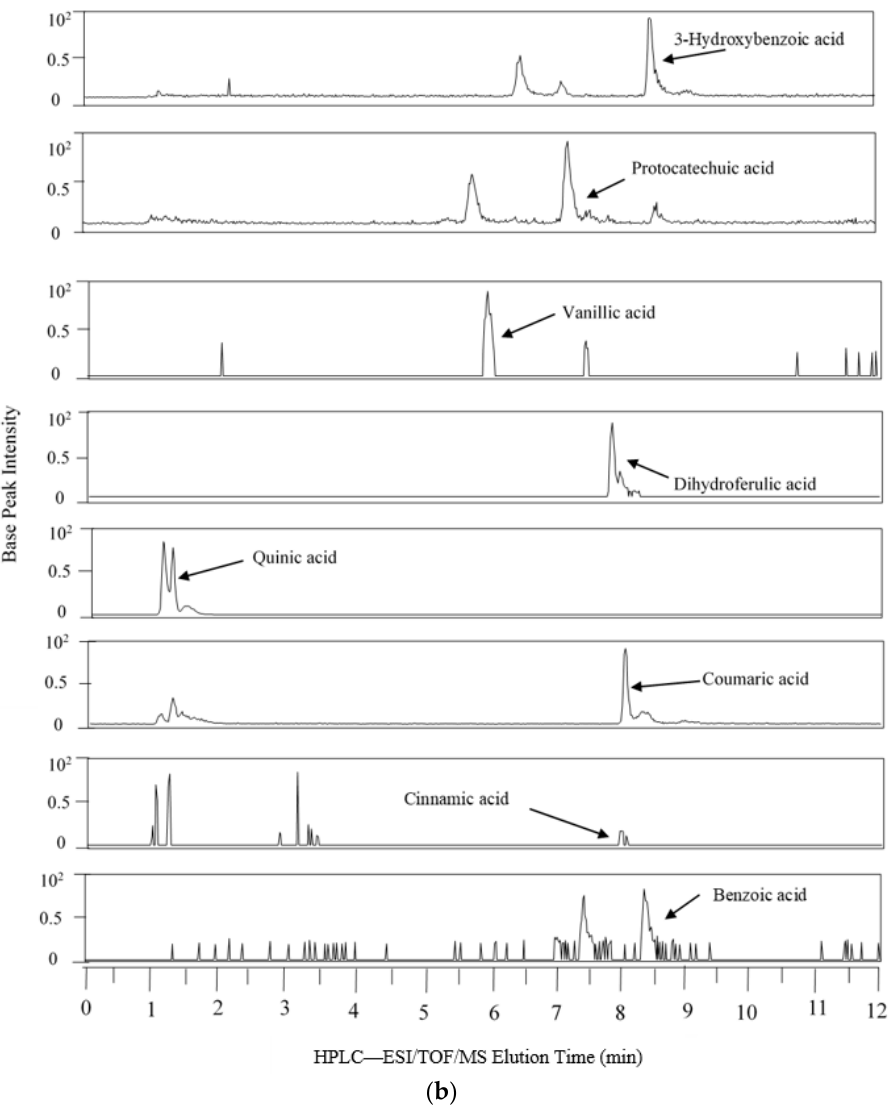
Figure 1. Representative extracted ion chromatograms from colonic vessels after 24 h of PRPE fermentation. HPLC-ESI/TOF/MS: High Performance Liquid Chromatography-Electrospray Ionization/Time of Flight/Mass Spectrometry. ( a ) AC; ( b ) AC continued.